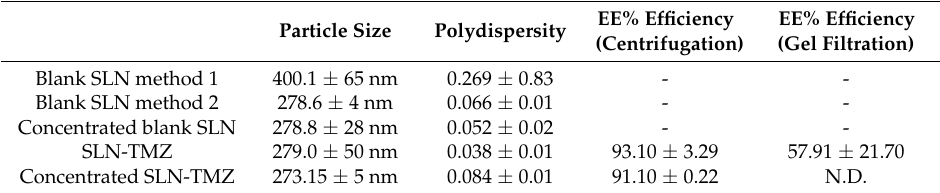
Table 2. SLN particle size and encapsulation efficiency